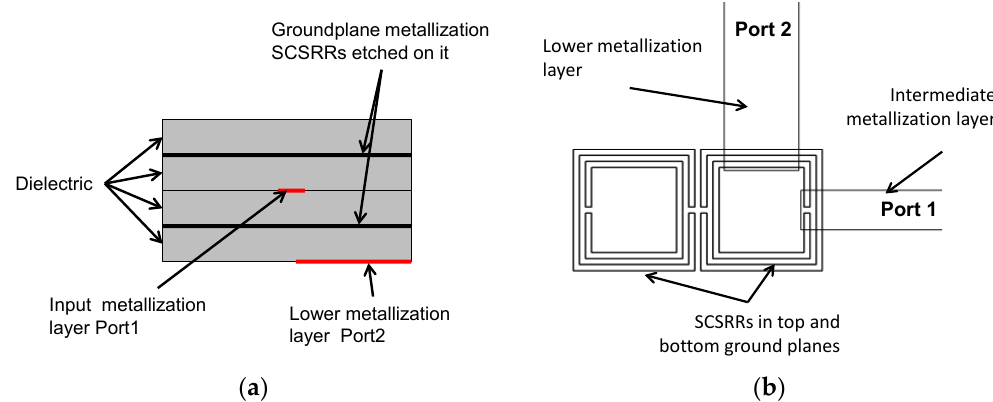
Figure 15. ( a ) Front view. Stacked layer distribution: ( b ) top view of the SCSRR multi-frequency resonator.